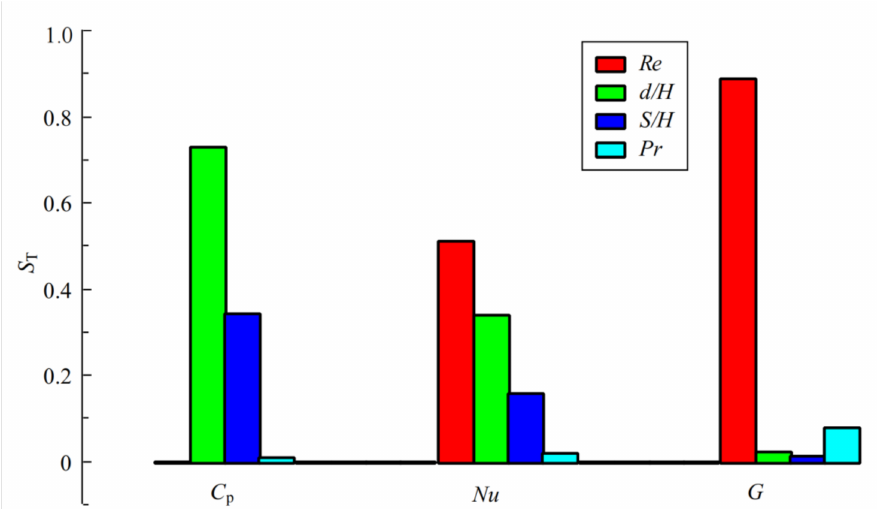
Figure 16. Distribution of the total sensitivity